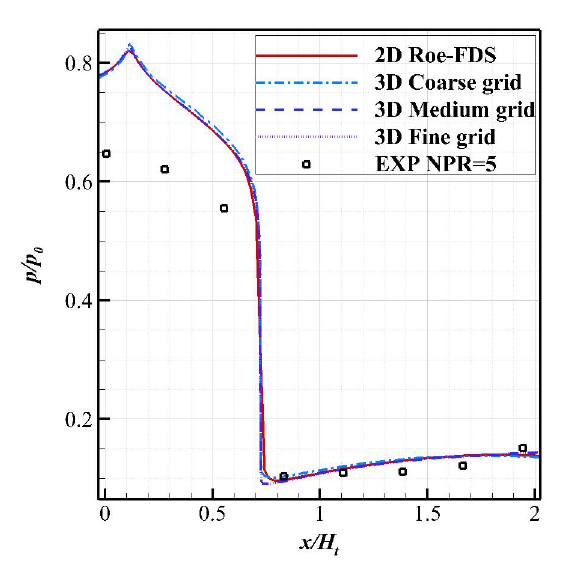
Figure 4. Pressure distributions of different grids on the ramp centerline surface at NPR = 5.